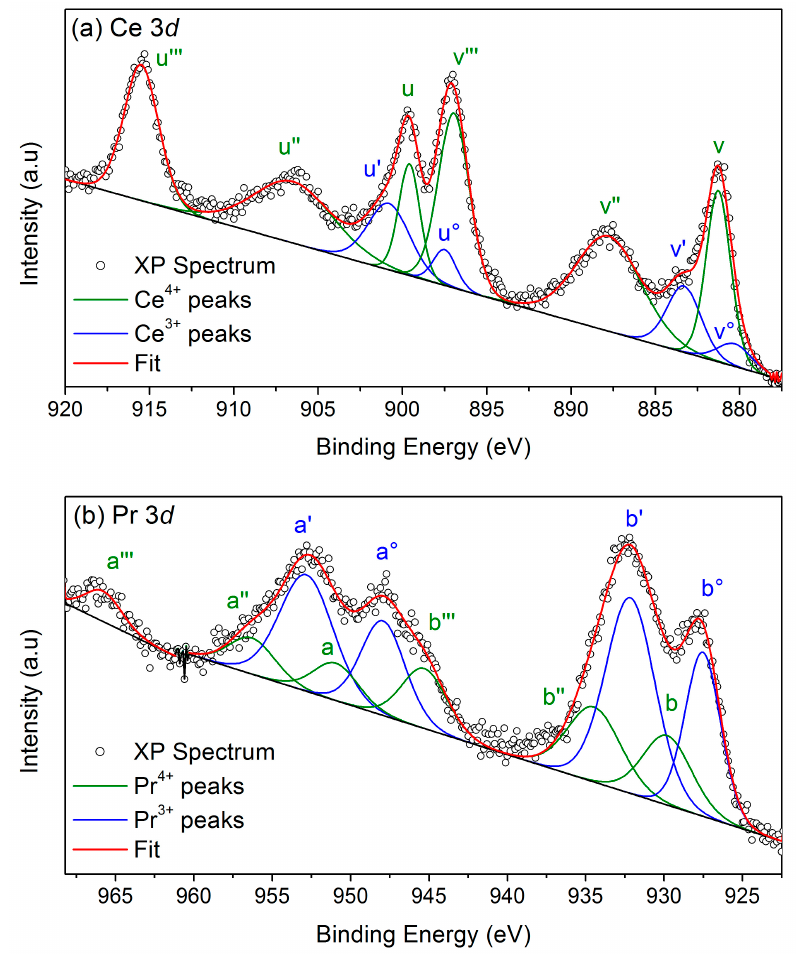
Figure 5. Deconvoluted XP spectra of the Ce50Pr50 catalyst in the ( a ) Ce 3d and ( b ) Pr 3d core levels regions.